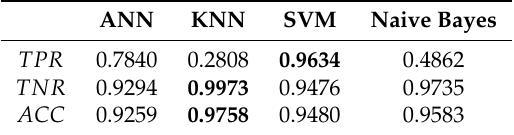
Table 7. Classification accuracy for different algorithms after the training set is balanced. ANN KNN SVM Naive Bayes